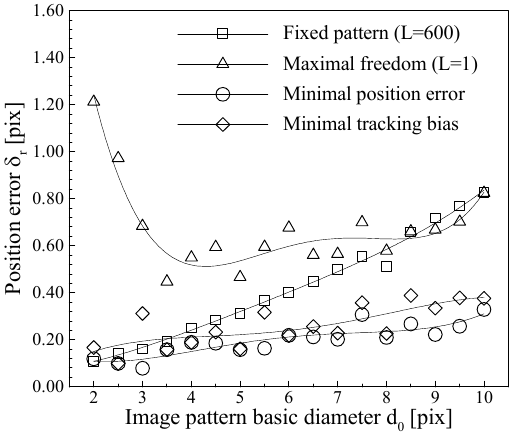
Figure 7. Position error distributions on image pattern size for different tracking freedom limits.